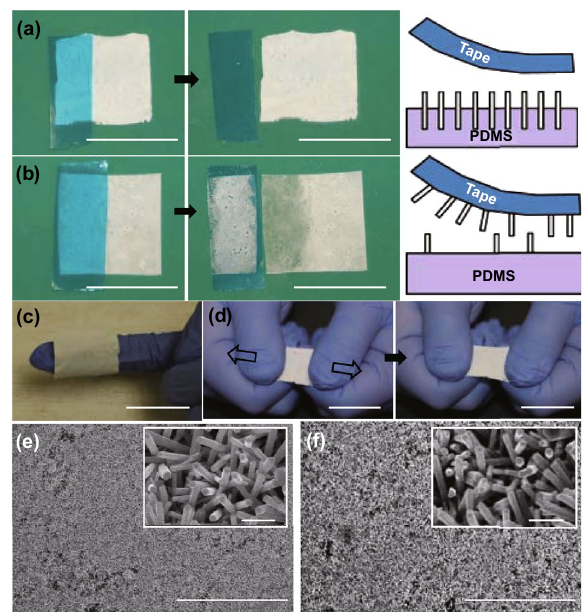
Fig. 5 a , b Photographs and schematics of the tape test on a ZP film (1 × 1 in. 2 ) and direct ZnO NW array growth film (1 × 1 in. 2 ). c , d Photographs of a ZP film wrapped on a finger and stretched to more than 50% of the original length, respectively. e , f SEM images of a ZP film after tape test and other chemical and mechanical tests. Scale bar: c – e 1 in, e – f 50 μm in the large view and 1 μm in the